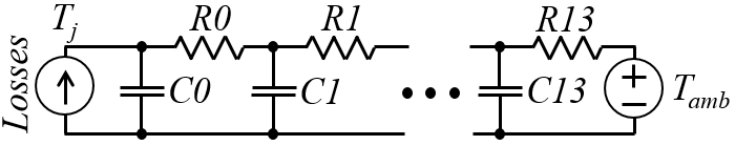
Figure 14. Thermal resistance and capacitance network representing the thermal impedance between the SiC MOSFET junction and SiC power module case (reference CCS050M12CM2).